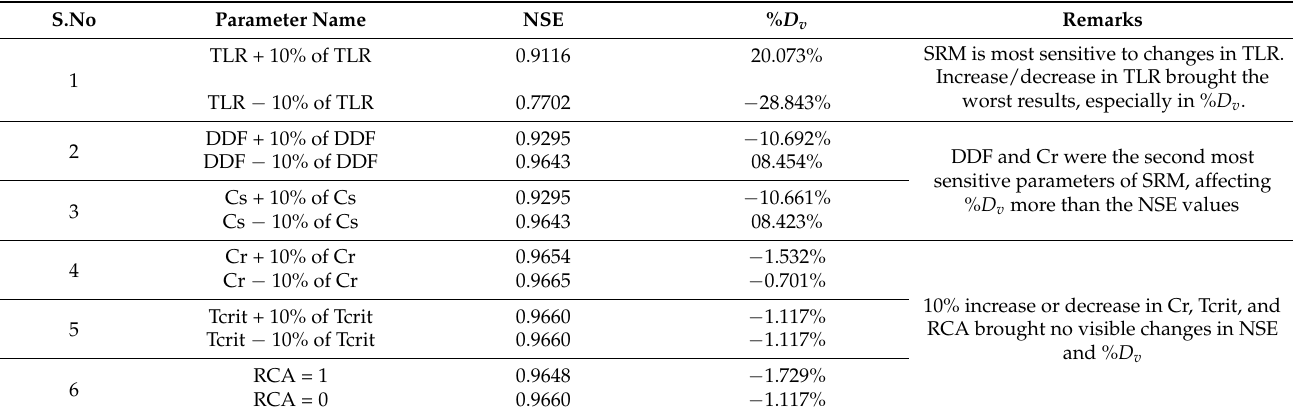
Table 2. Sensitivity analysis of SRM (Original Results: NSE = 0.966 and % D v = −